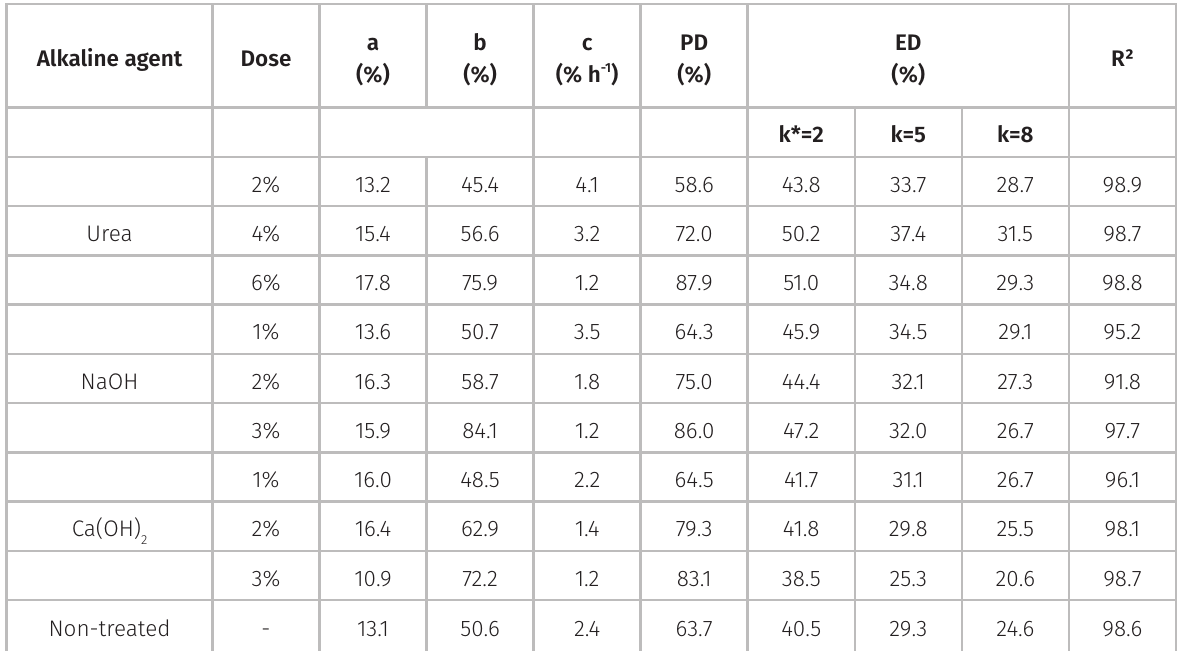
Table II. Soluble ( a ) and potentially degradable ( b ) fractions, degradation rate ( c ), potential (PD) and effective (ED) degradability, and coefficient of determination (R²) for dry matter of sugarcane tip hay treated or not with alkaline